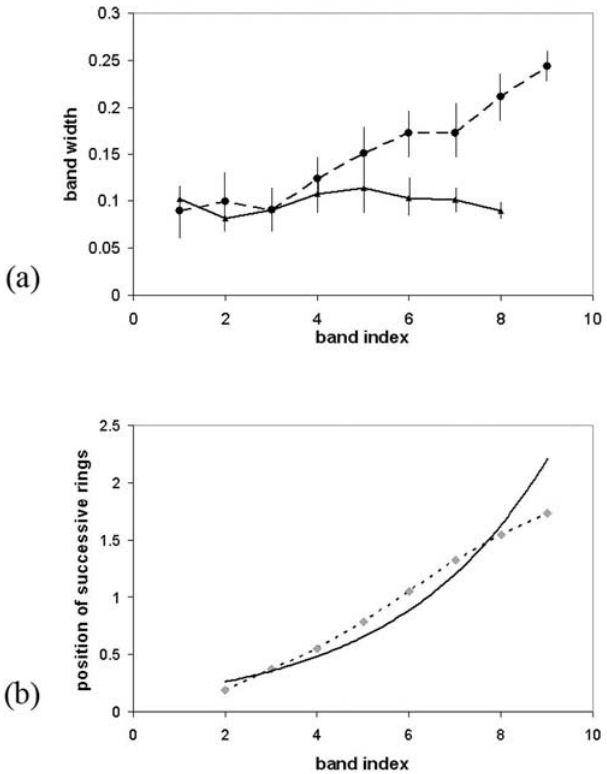
Figure 2. Space laws from 12 measures made on the cases of Balo´ (1928) Arch Neurol Psychiatr 19 :242–264 and Hallervorden et al. [2]. (a) Damaged (dashed line) and preserved (solid line) myelin. (b) Averaged successive positions of destroyed myelin bands (dashed), compared to the classical exponential space law for the Liesegang rings (solid line) obtained from a logarithmic regression; y-axis label in cm s. The space law for concentric sclerosis is linear (correlation coefficient r 2 =0,996). In all our mathematical models, the space law strongly depends on the shape of the activating front. As the biological nature of this front is unknown, selection between different scenarios (e.g. preconditioning model vs. local macrophage recruitment model) cannot be based on the space law. However the linear law for concentric sclerosis tends to indicate that an outer diffusing signal is unlikely.